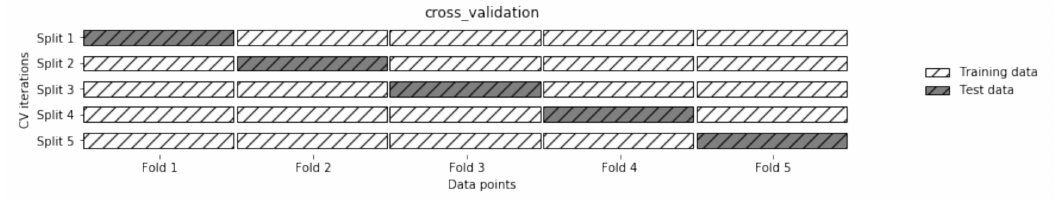
Figure 10. The whole process of 5-fold cross